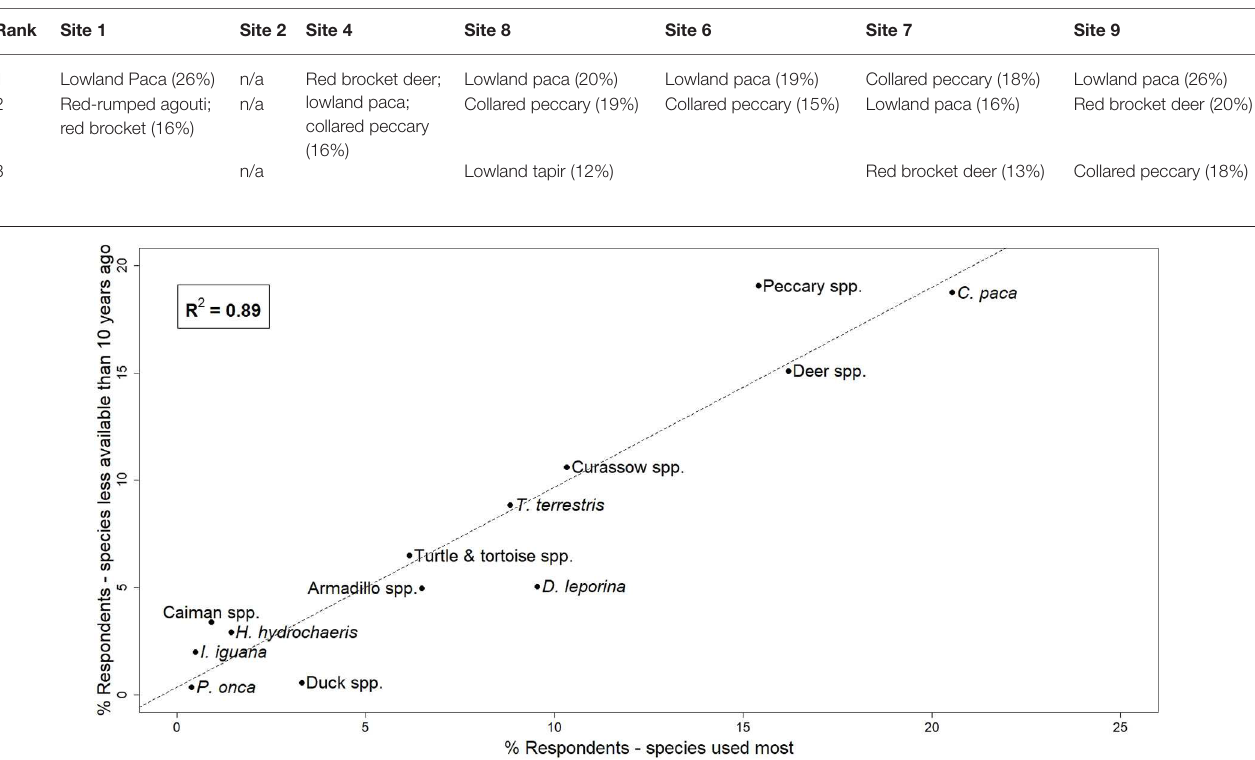
TABLE 2 | The top three most hunted species at each